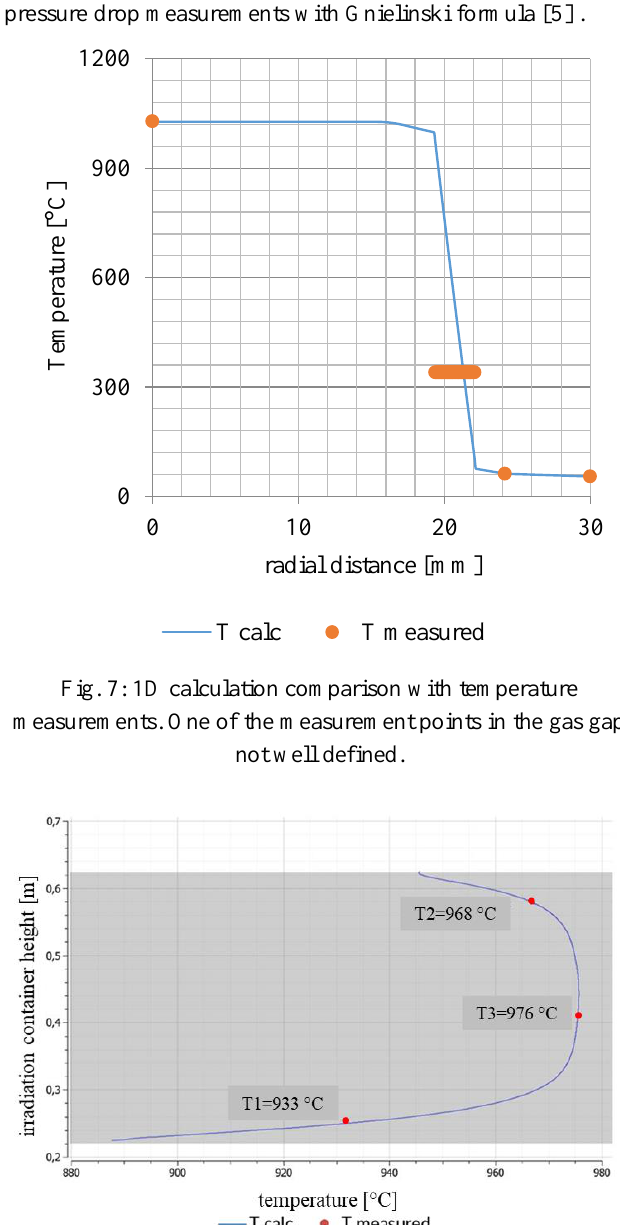
Fig. 6: Time series of the experiment.